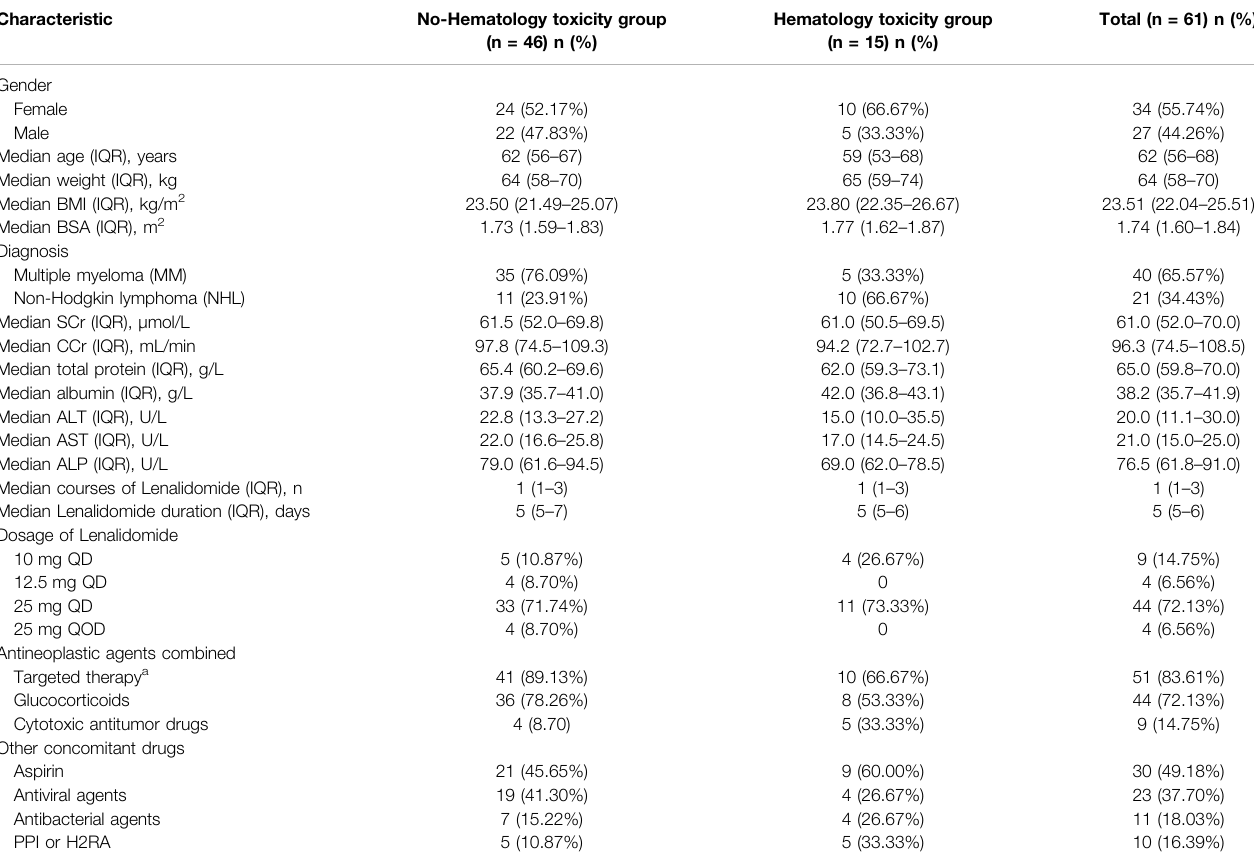
TABLE 1 | Baseline demographic and clinical characteristics of the included patients.